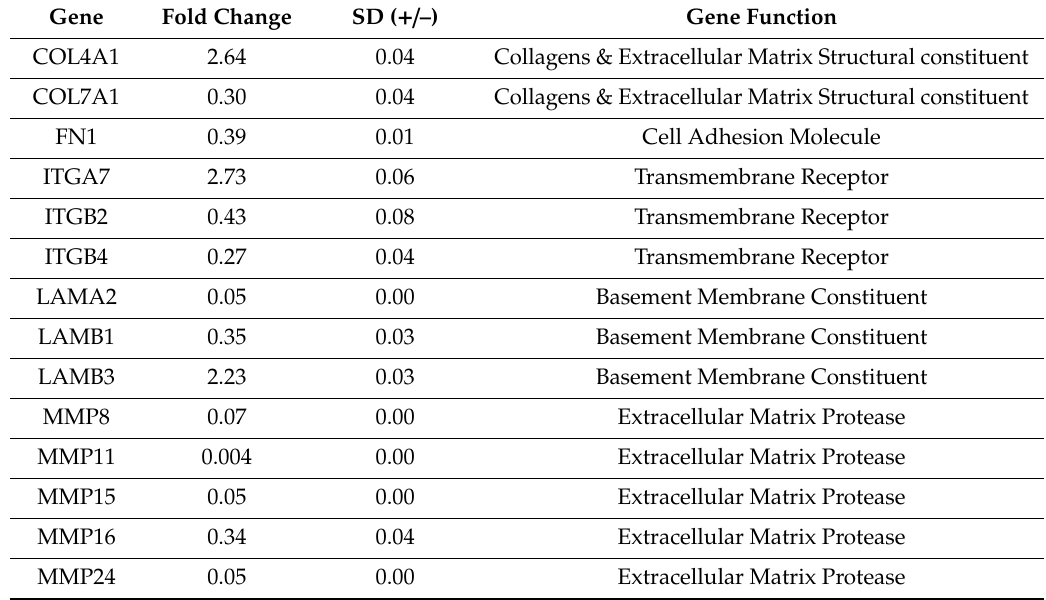
Table 4. Significant gene expression levels after 24 h of treatment with gabapentin compared with the untreated